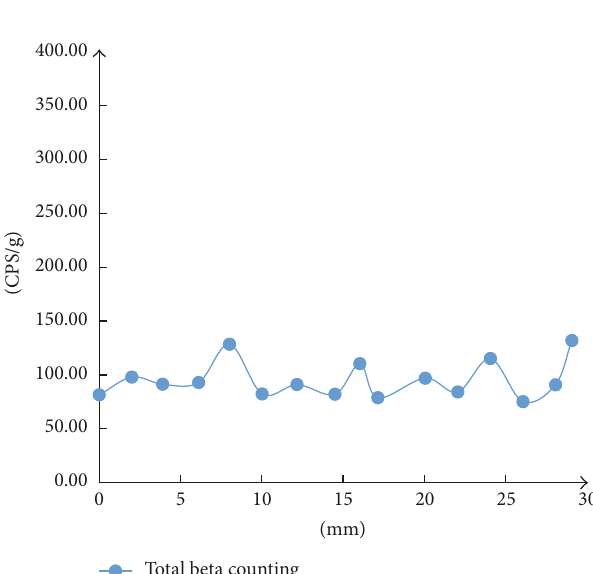
Figure 10: Total 𝛽 count per gram of graphite at different spherical